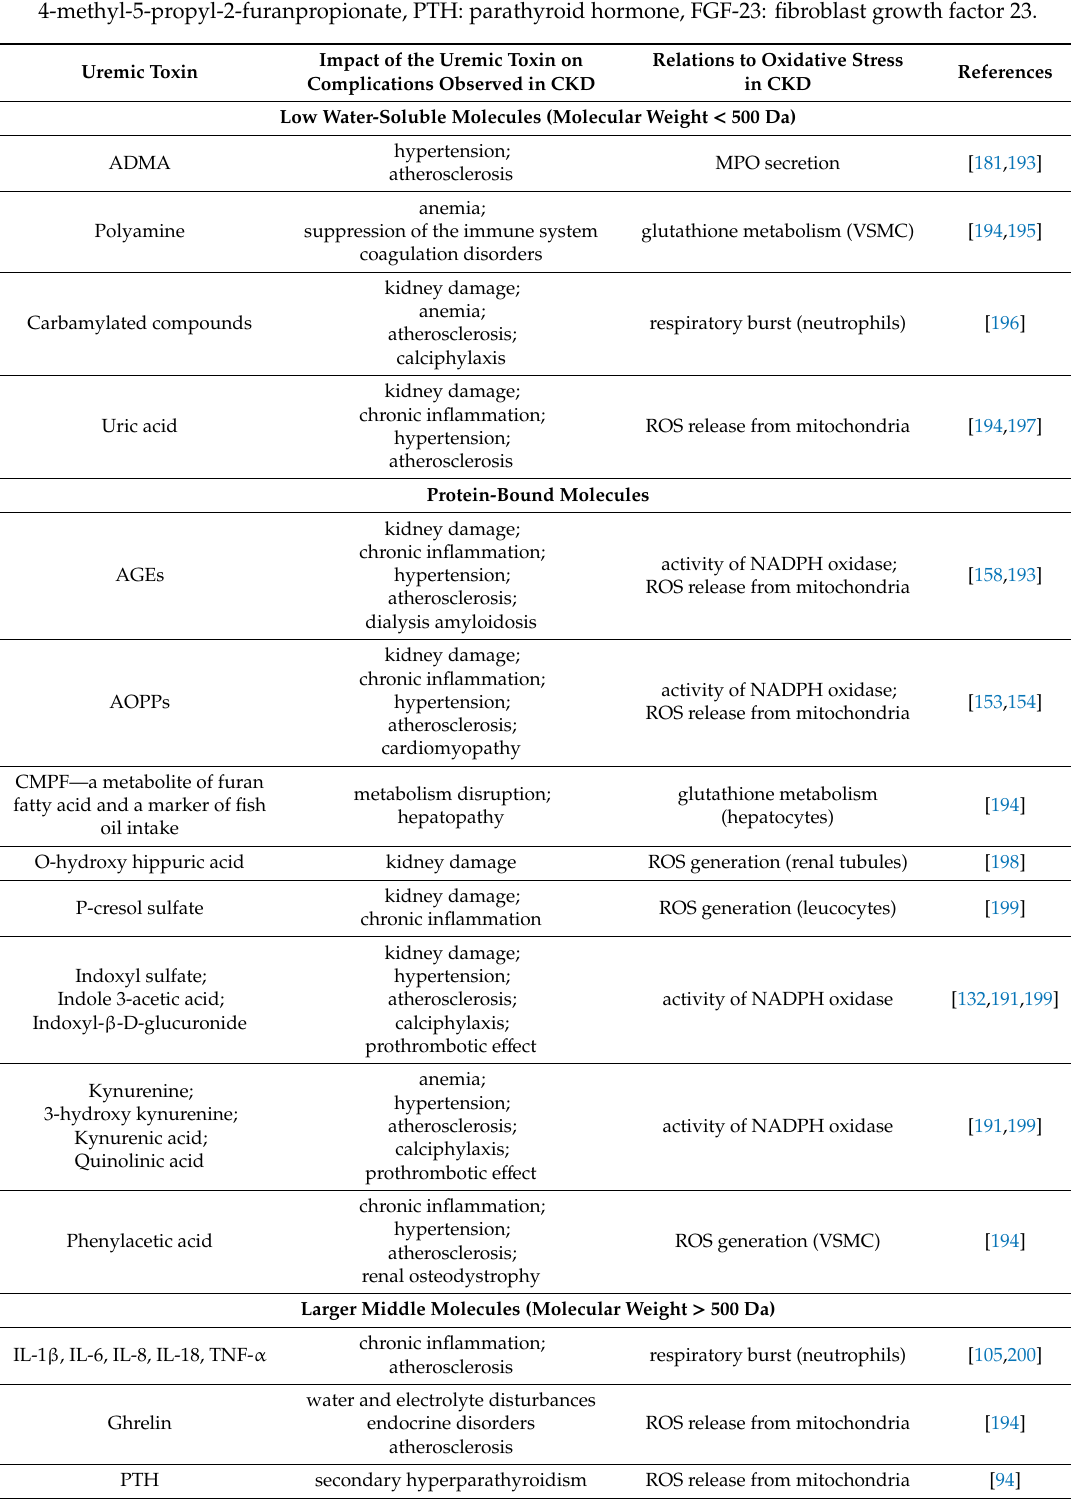
Table 3. Selected uremic toxins with their impact on CKD and relation to oxidative stress. ADMA: asymmetric dimethylarginine, MPO: myeloperoxidase, AGEs: advanced glycation end products, AOPPs: advanced oxidation protein products, VSMC: vascular smooth muscle cells, CMPF: